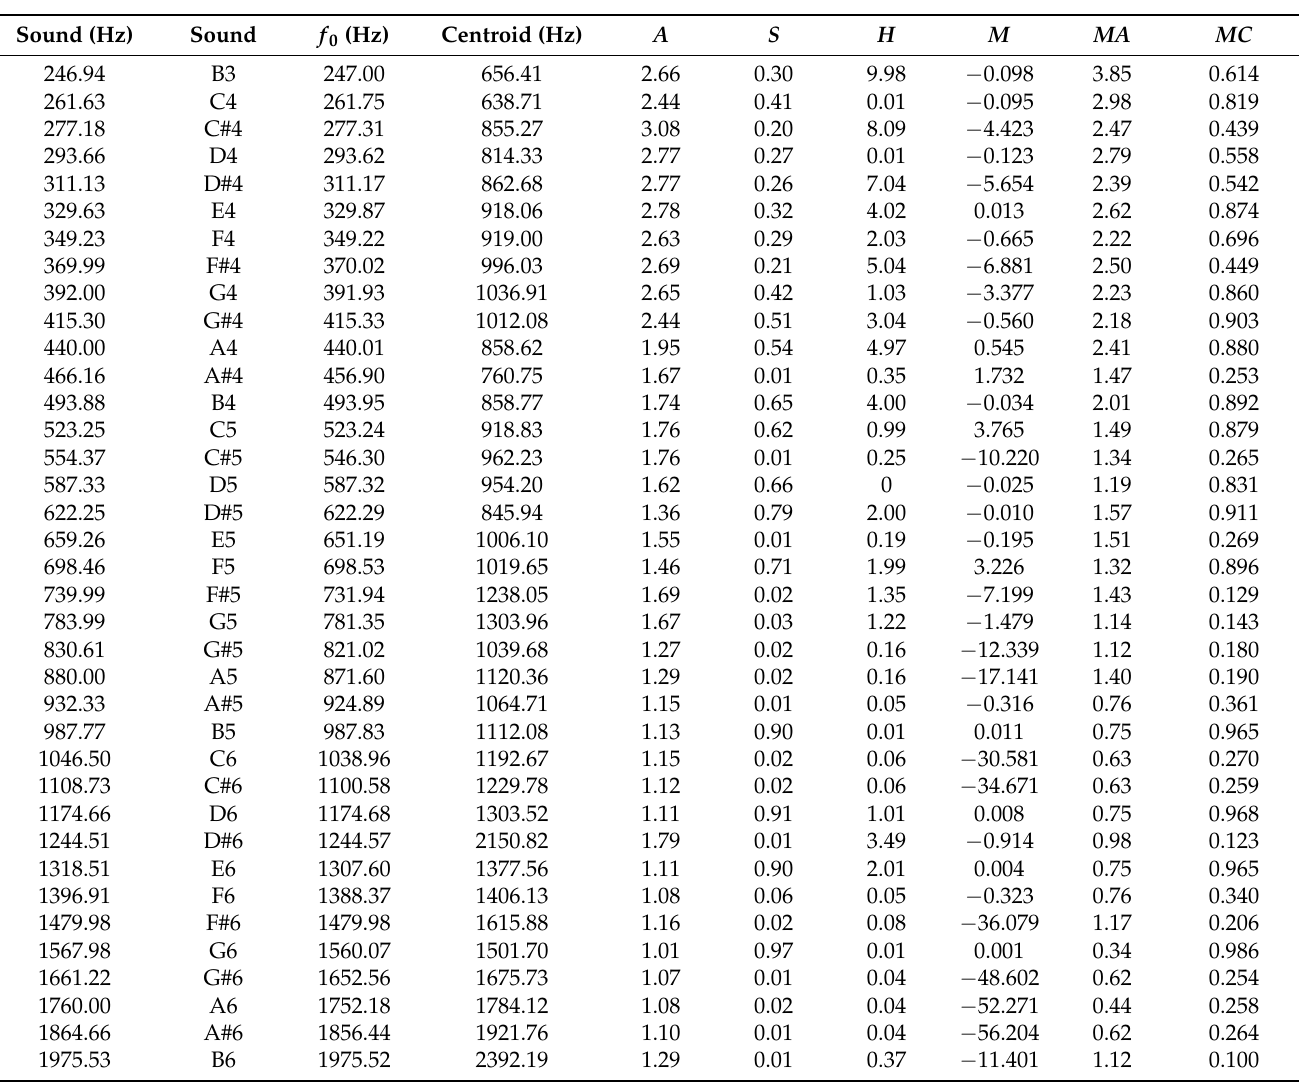
Table A4. Transverse Flute